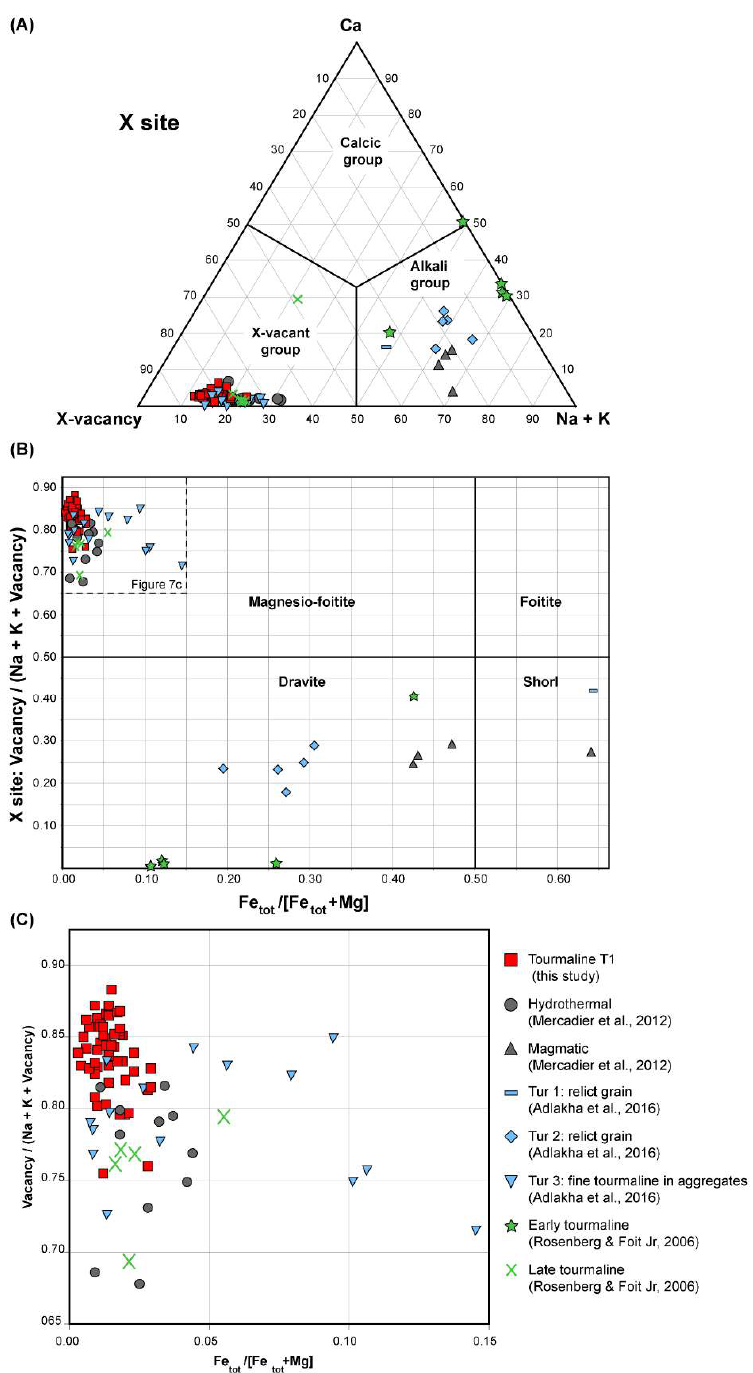
Figure 7. Classification of tourmaline T1 at the Ranger U deposit (Australia) and for different generations of tourmaline in other unconformity‐related U deposits from the Athabasca Basin (Canada [31,33,56]) [48]. ( A ) Ca‐Na + K‐X‐site vacancy ternary diagram showing the X‐site occupancy; ( B ) binary diagram showing the Fe tot /(Fe tot + Mg) versus X‐site vacancy/(X‐site vacancy + Na + K) ratios; ( C ) zoom on the Mg‐foitite domain on the Fe tot /(Fe tot + Mg) versus X‐site vacancy/(X‐site vacancy + Na + K) diagram. For Canadian deposits, “Hydrothermal” (Mercadier et al. [33]), “Tur 3” (Adlakha et al. [31]) and “Late tourmaline” (Rosenberg and Foit Jr., [56]) correspond to Mg‐foitite. Note that each point for “Hydrothermal”, Magmatic” (Mercadier et al. [33]), “Tur1”, “Tur2”, “Tur3” (Adlakha et al. [31]),“early” and “late tourmaline” (Rosenberg and Foit Jr [56]) compositions correspond to the mean values for each sample or generation.